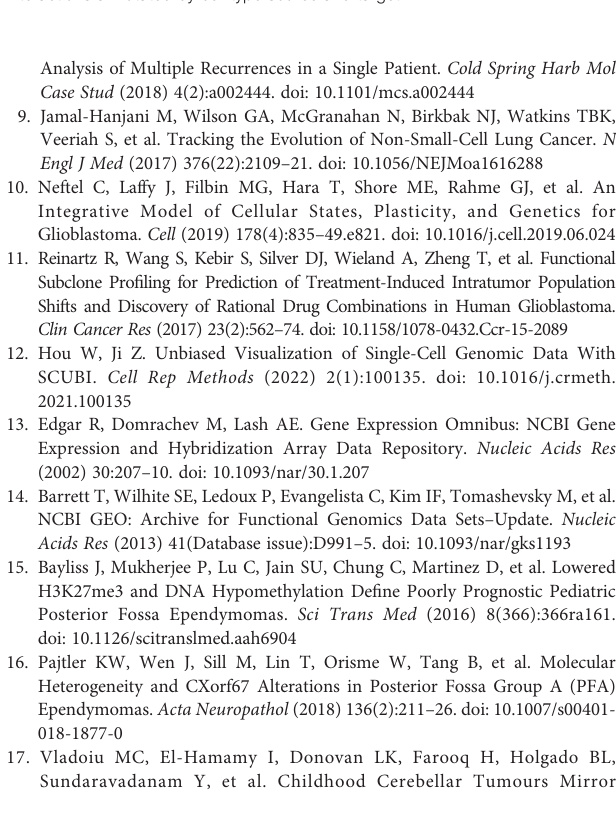
Supplementary Table 1 | Clinical data from EPN patients. Clinical data of four sequenced EPN samples from patients in this study. Supplementary Table 2 | Signatures for cell type classi fi cation. For recognition of cell type in SE algorithms, Seurat was used to calculate the DEGs (latter utilized as signatures) of each cell type from each reference data 12-16,62 which included RGC, AS, EC, EpC, NEU, NSC, OD, OPC, Mic, and T cells, from human and rodent embryonic and postnatal cortex scRNA-seq data. Supplementary Table 3 | Differentially expressed genes between subclones of the sample GTE009. Differentially expressed genes calculated from subclone 1 compared to the subclone 2 of the sample GTE009. Supplementary Table 4 | Analysis on cilium-related genes and CNV score. DEGs calculated from subclone 1 compared to the subclone 2 of the sample GTE009 marked by GO terms, annotated with results of statistical analysis from CNV